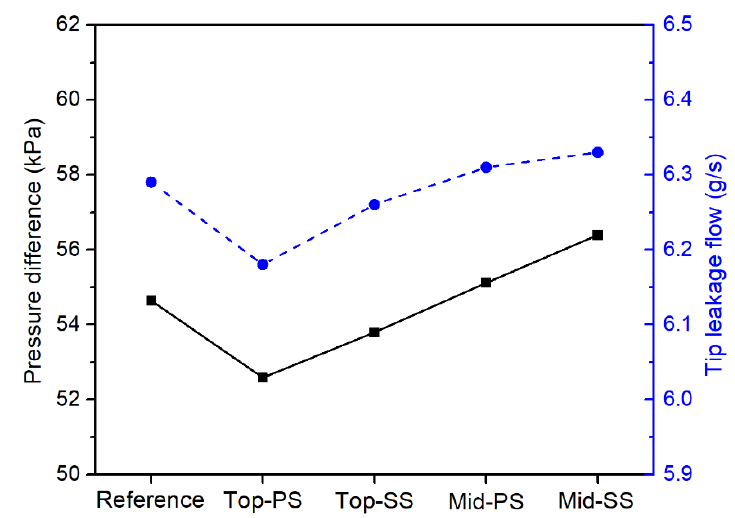
Figure 10. Pressure difference between pressure side and suction side of the R 1 blade and tip leakage flow through the R 1 blade tip.